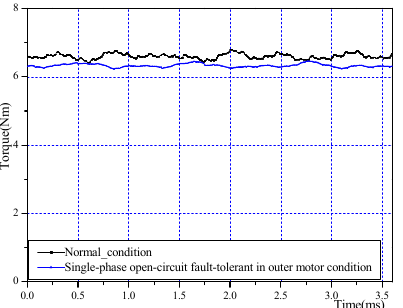
that the outer motor can be controlled separately when faults occur in it.